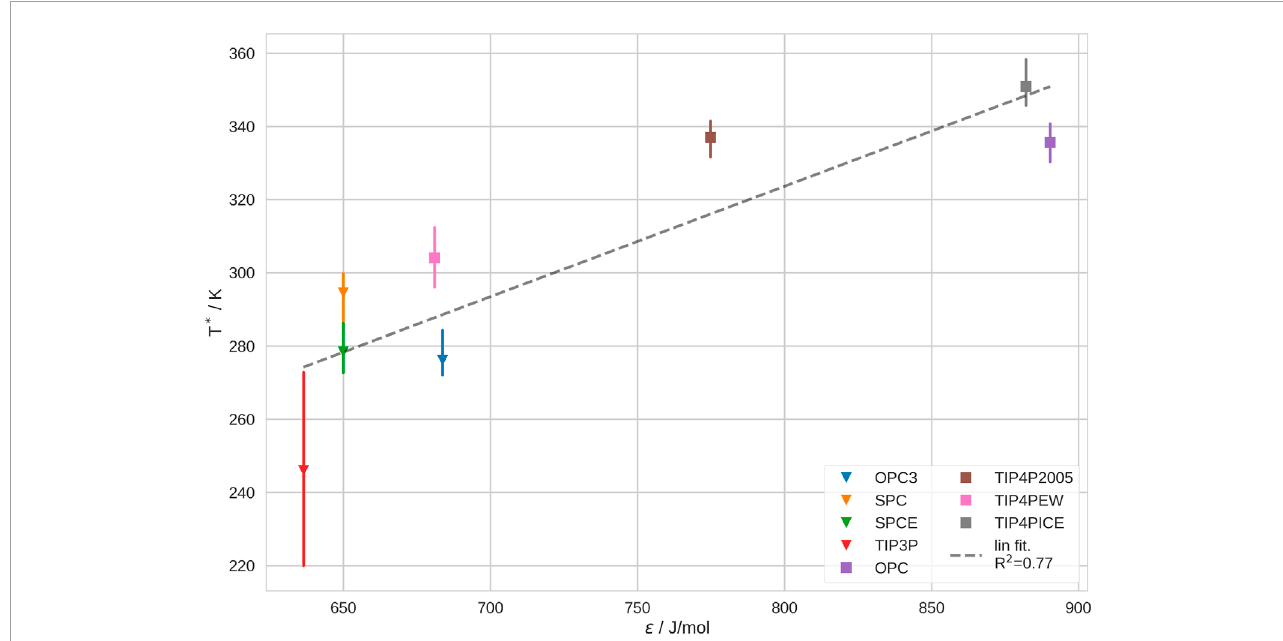
FIGURE 5 Coil-Globule transition temperature, T *, in different water models vs . the Lennard-Jones parameter, ϵ , of the respective water models. We show the estimated mean and min./max. of T * from leave-one-out cross-validation. 3-point water models are depicted as triangles, 4-point water models as